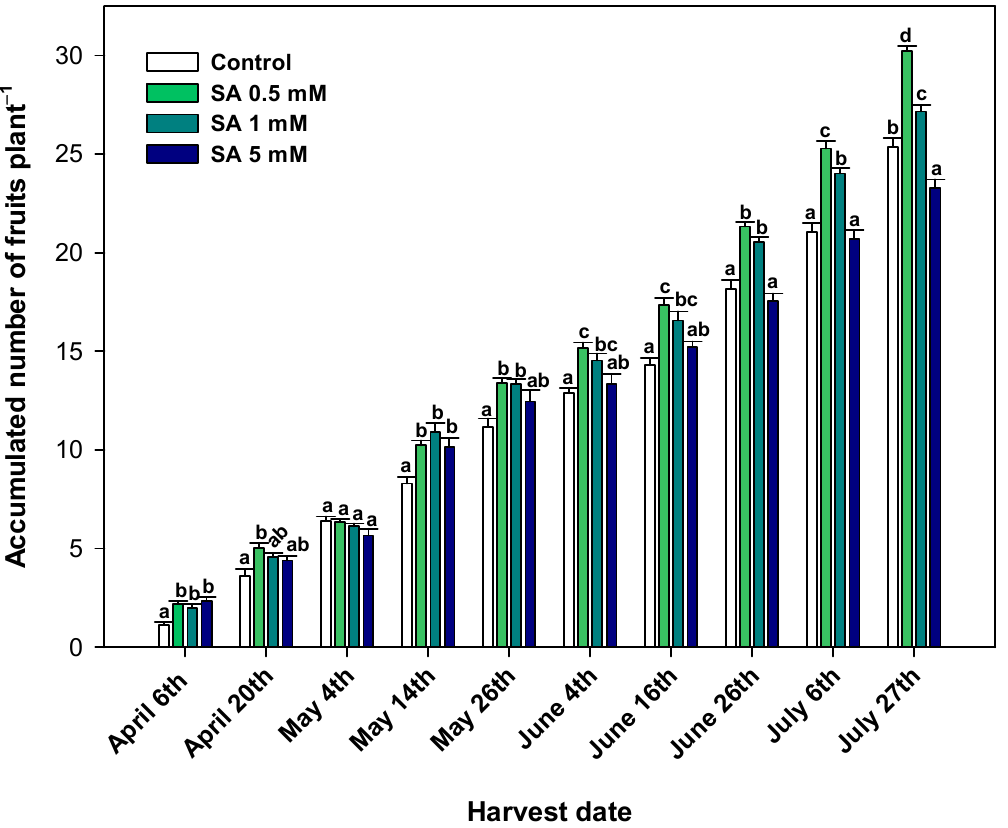
Figure 2. Accumulated number of pepper fruits per plant (number of fruits plant − 1 ) throughout the developmental and growth cycle of green pepper fruit as affected by salicylic acid (SA) preharvest treatment at 0.5, 1 and 5 mM in the 2020 experiment. Data are the mean ± SE. Different lowercase letters show significant differences among treatments for each harvest date at p < 0.05.